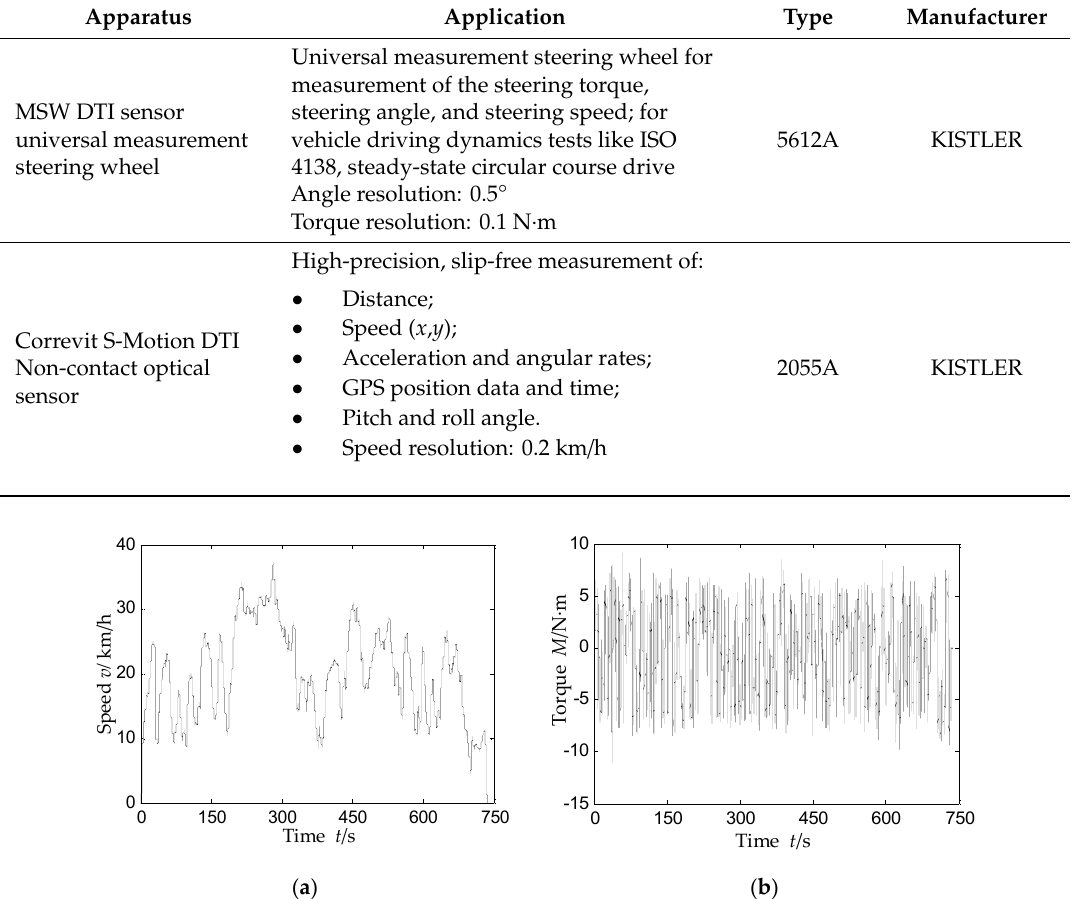
Figure 6. The collected signals in the test: ( a ) vehicle speed; ( b ) steering wheel torque.